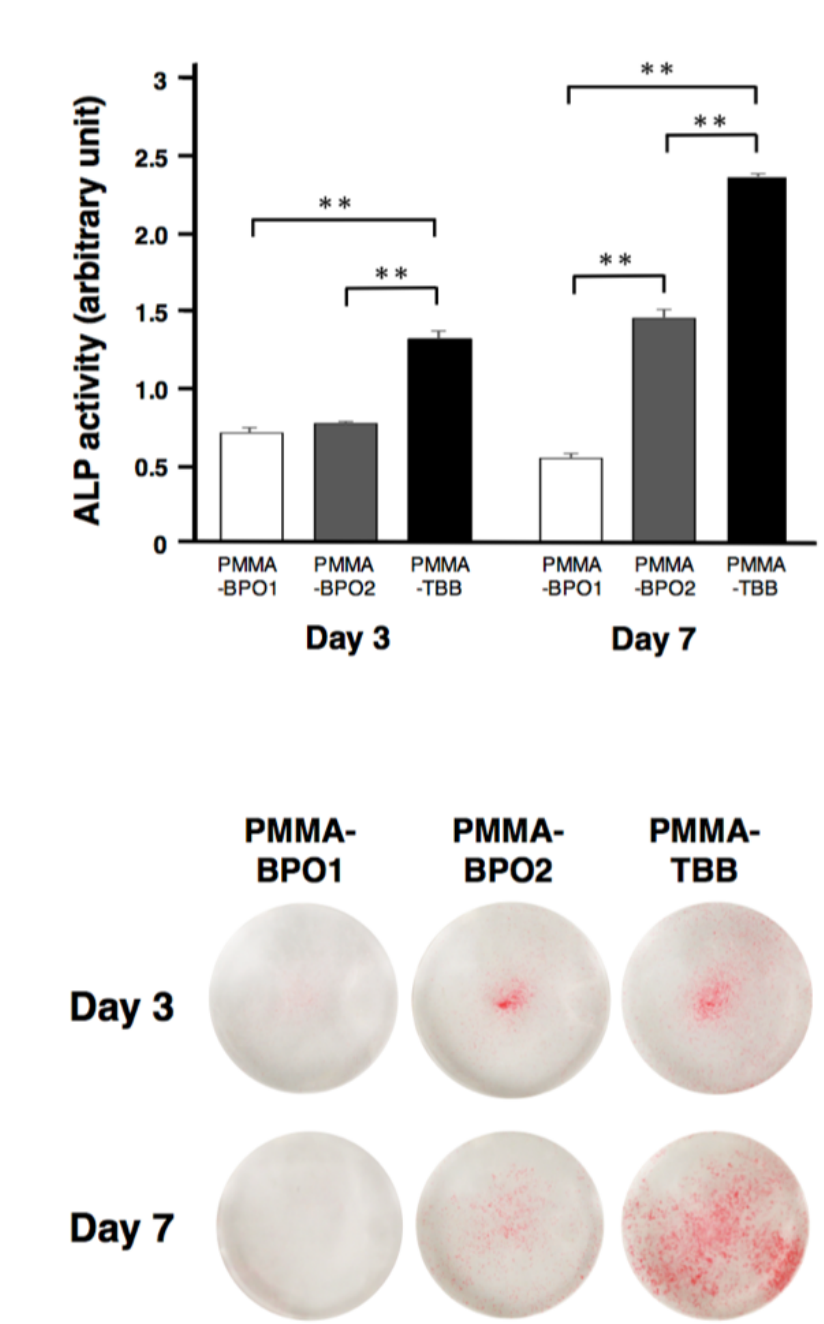
Figure 4. Differentiation of osteoblasts exposed to three different bone cement extracts. Alkaline phosphatase (ALP) evaluation of osteoblasts exposed to three different bone cement extracts 3 and 7 days after seeding. ( A ) Colorimetric quantification of ALP activity. ( B ) Representative images of ALP staining. Data shown are mean ± SD ( n = 3). Significant differences between the three groups are shown (one-way ANOVA followed by Bonferroni correction, ** p < 0.01).